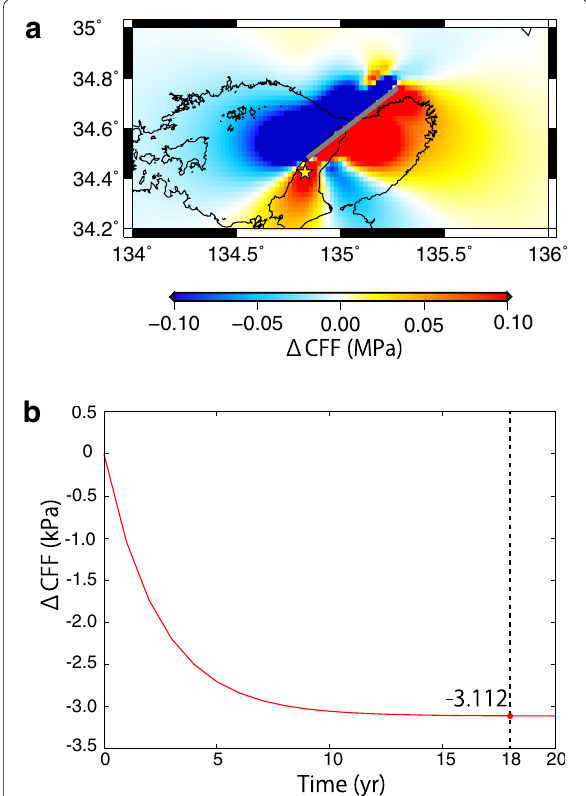
Fig. 11 Stress transferred by 1995 M w 6.9 Kobe earthquake. a Coseismic Coulomb stress change at a depth of 14.4 km due to the slip model from Ide and Takeo (1997). The receiver fault is assumed to be the 2013 Awaji Island earthquake fault: (strike, dip, slip) 62°, 101°). The star corresponds to the epicenter of the Awaji Island earthquake. The surface projection of the fault model of the Kobe earthquake is indicated by the gray rectangle. b Coulomb stress change at the hypocenter of the Awaji Island earthquake due to the viscoelastic relaxation following the Kobe earthquake. The horizontal axis indicates elapsed time after the Kobe earthquake. The vertical broken line corresponds to the occurrence of the Awaji Island